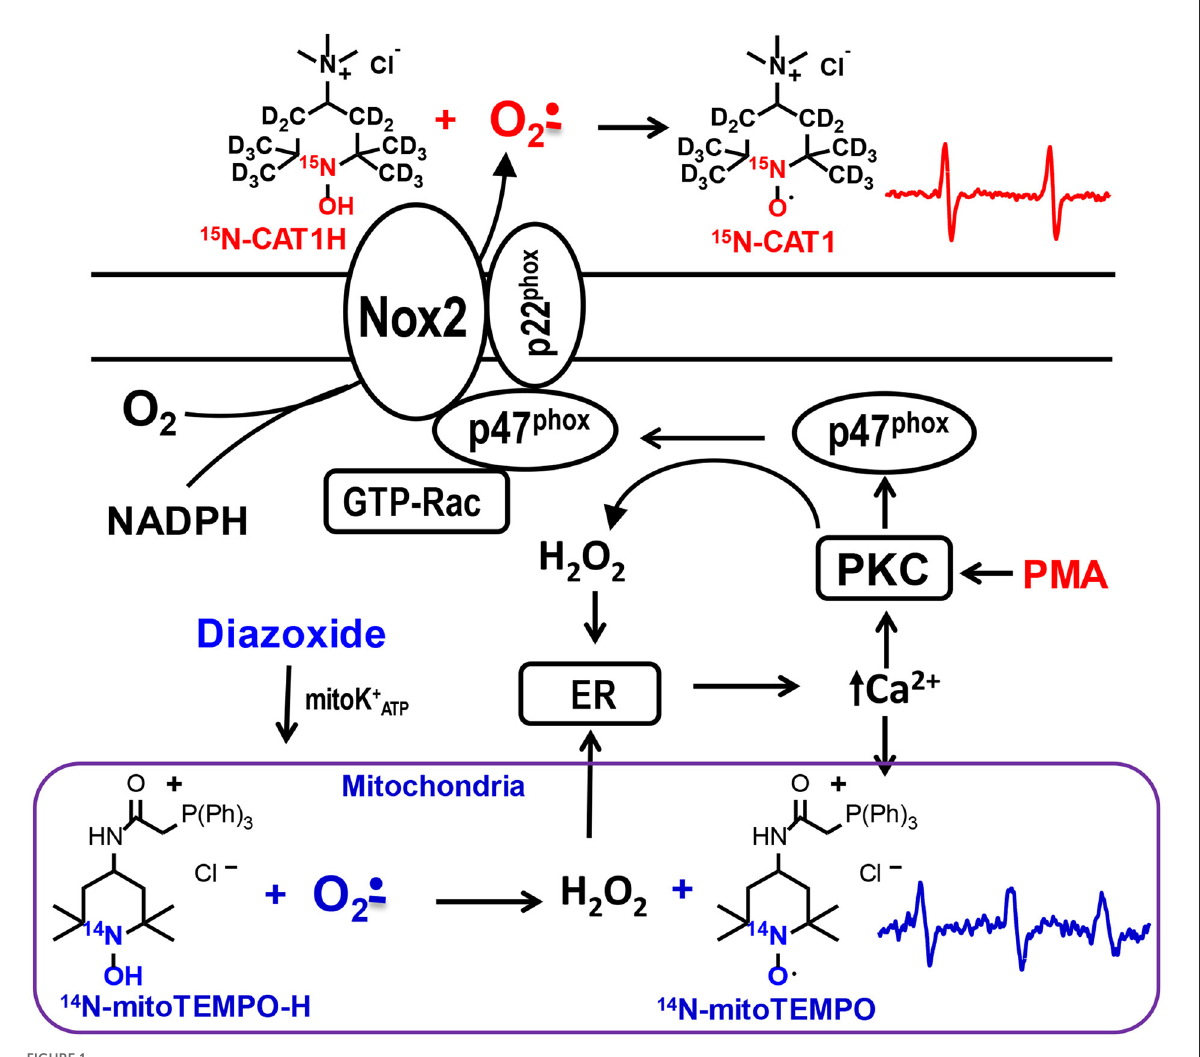
FIGURE1 Schematic presentation of site-specific localization of 15 N-CAT1H and 14 N-mitoTEMPO-H spin probes allowing separate detection of extracellular and mitochondrial superoxide production by phagocytic NADPH oxidase and mitochondria in splenocytes. 15 N-CAT1H and 14 N-mitoTEMPO-H are added to splenocytes at 500 µ M and 25 µ M correspondingly which results in detection of extracellular superoxide predominantly by cell impermeable 15 N-CAT1H due to its excess by 20-fold compared with 14 N-mitoTEMPO-H. Meanwhile, cell permeable